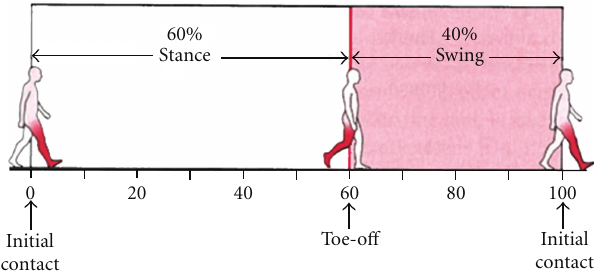
Figure 2: The gait cycle can be divided into the stance phase (weight-bearing) and swing phase (non-weight-bearing). Reprinted with permission: Elsevier Books (2857691435547).